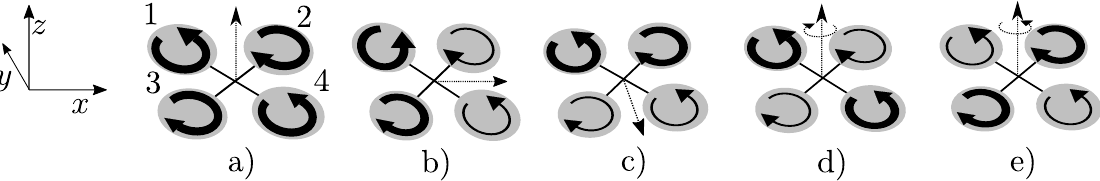
Figure 2. Illustration of the concept of the motion of a quadrotor. Let the propeller rotation speed be proportional to the width of the arrow on the propeller; the movement of the UAV is denoted with the dashed arrow at the center of the quadrotor. (a) Upward movement, (b) horizontal movement, (c) downward movement, (d) left turning movement and (e) right turning movement.